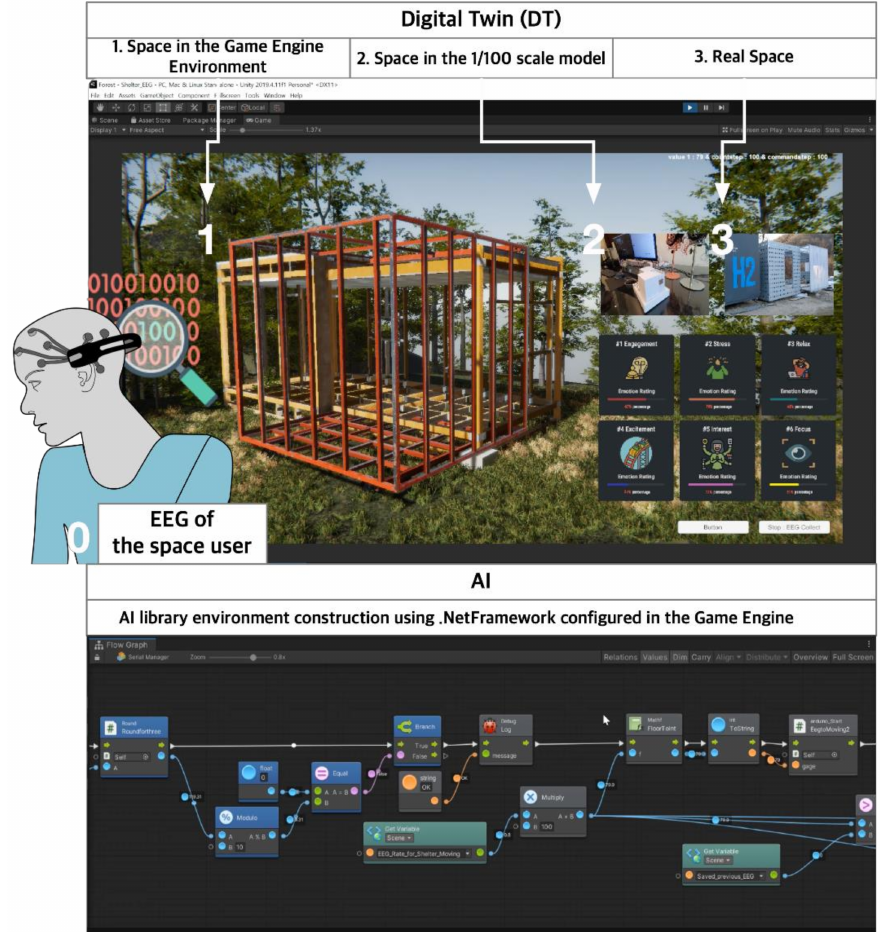
Figure 6. Fusion mechanism of DT and AI